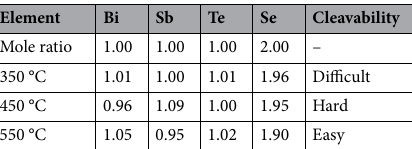
Table 2. EDS results at different growth temperatures for BSTS crystals.